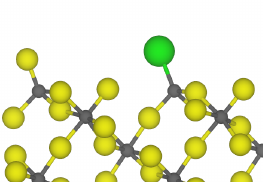
Figure 7. Relaxed structure of the terminally-substituted ACF- ( 01¯10 ) surface(grey = aluminum, yellow = fluorine, green =